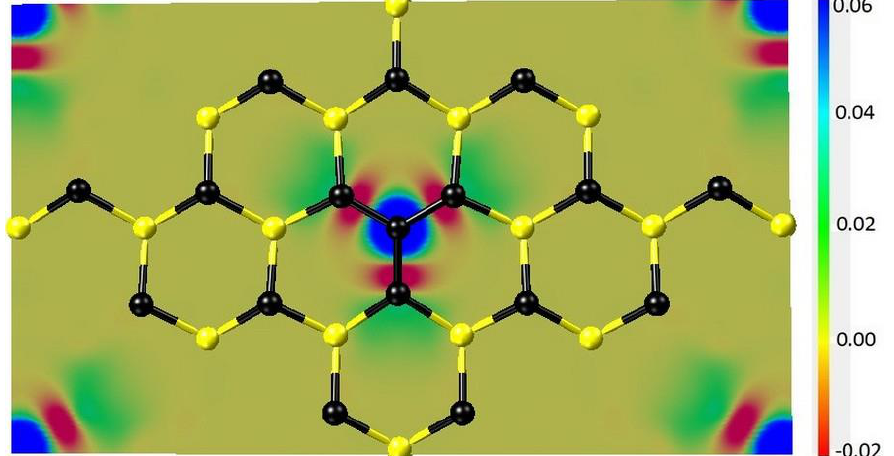
Figure 12. Projection of the difference in the density of spin-up and spin-down electrons onto the (100) plane passing through the centers of Si atoms just below the carbon cluster C 4 . The color scale spans from − 0.02 Å − 1 (red) to 0.06 Å − 1